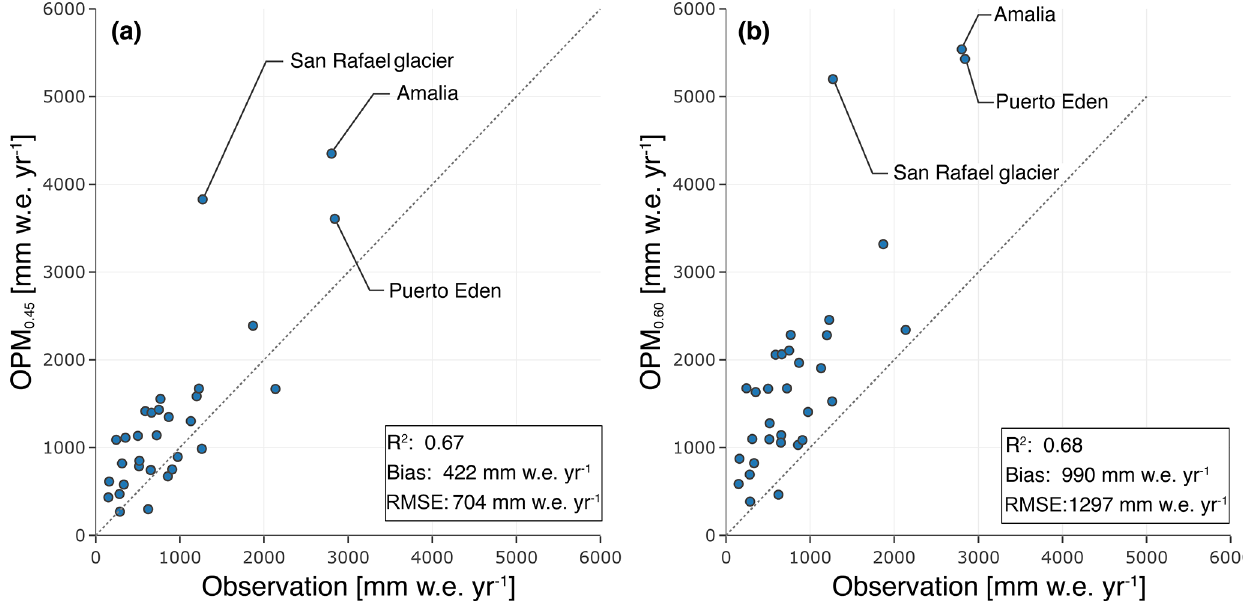
Figure 5. Comparison of measured and simulated precipitation for the period 2010–2016. The observations were made by the weather station network of the Dirección Meteorológica de Chile (DMC) and the Dirección General de Aguas (DGA). The only three stations located west of the Patagonian Icefield are